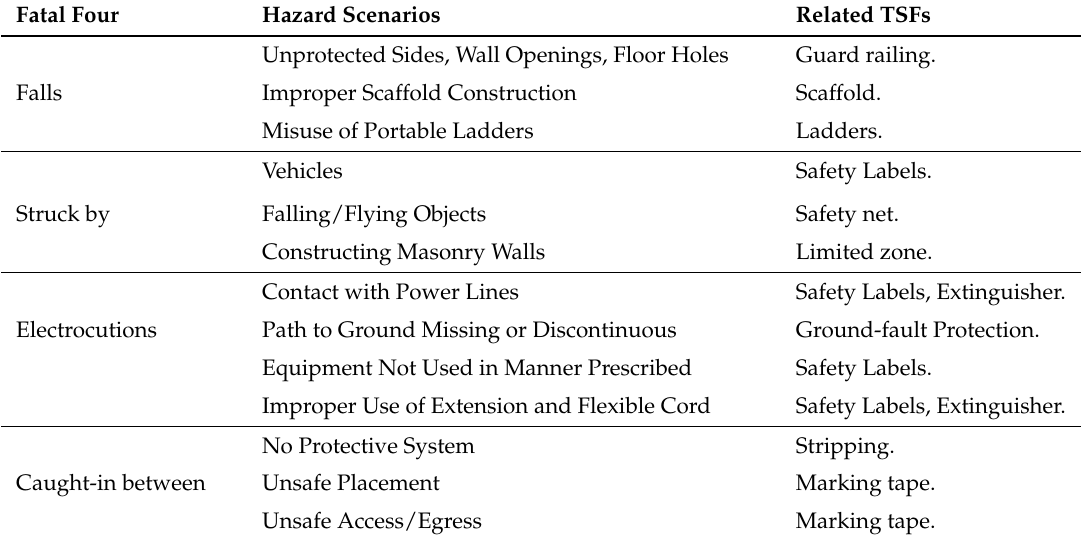
Table 3. Safety data